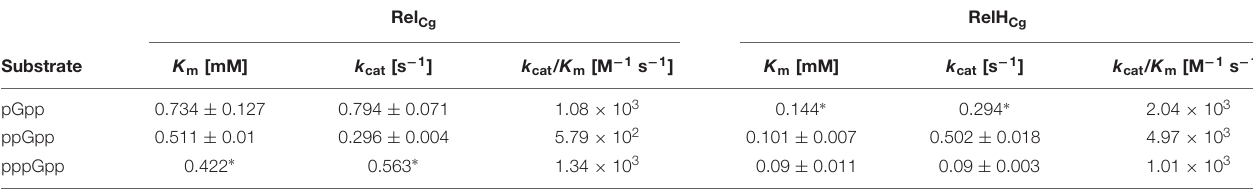
TABLE 3 | Specific enzyme parameters determined for the hydrolysis of pGpp, ppGpp, and pppGpp by Rel Cg and RelH Cg , respectively.